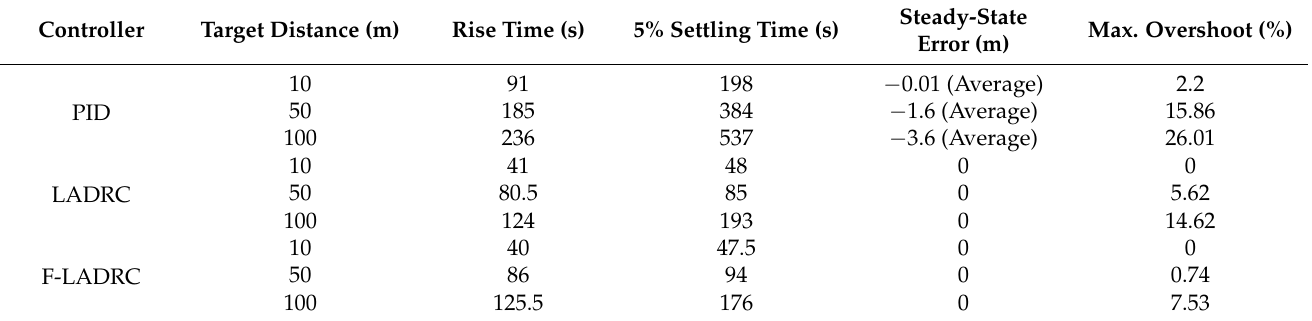
Table 6. Fuzzy rules for ∆ K 1 and ∆ K 2 with inputs e 1 and e 2 .